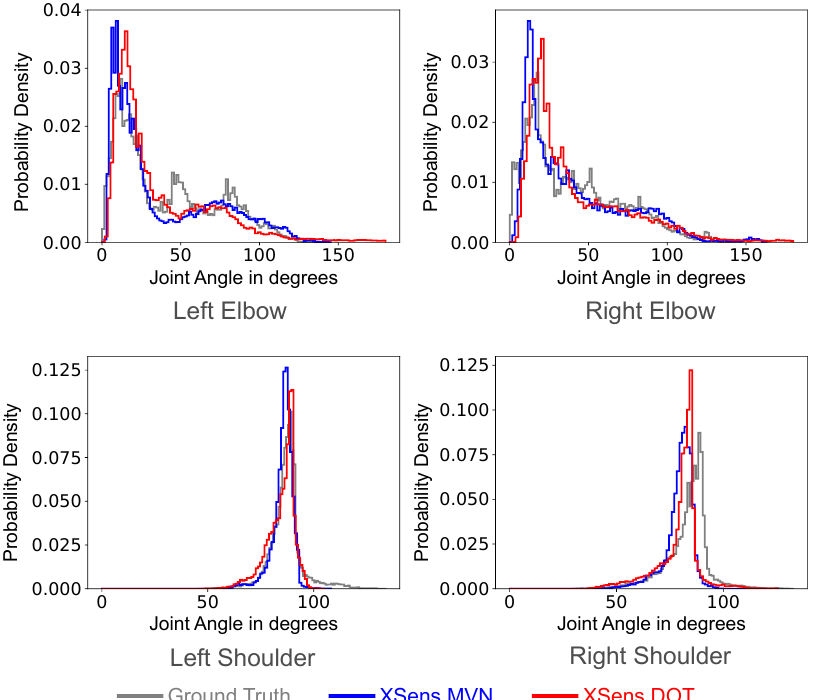
Figure 21. Joint angle distribution for selected joints. The blue histogram shows the joint angle distribution for the MVN segments, while the red histogram shows the joint angle distribution using the DOT sensors (variable mapping, Configuration 1). The grey histogram presents the ground truth for the corresponding joint angles. For the elbow, 0 ◦ corresponds to the arm straight.